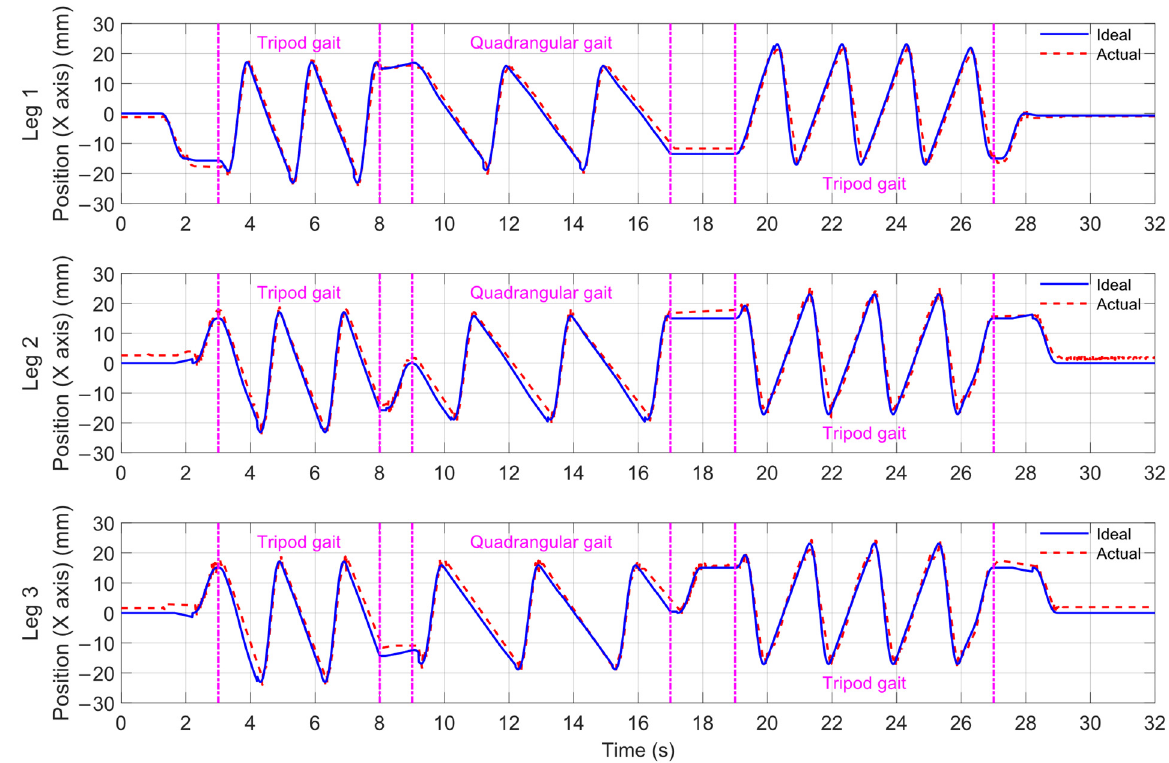
Figure 18. Comparison between the ideal foot trajectory and the actual foot trajectory of leg 1~3 in the experiment of gait transformation.